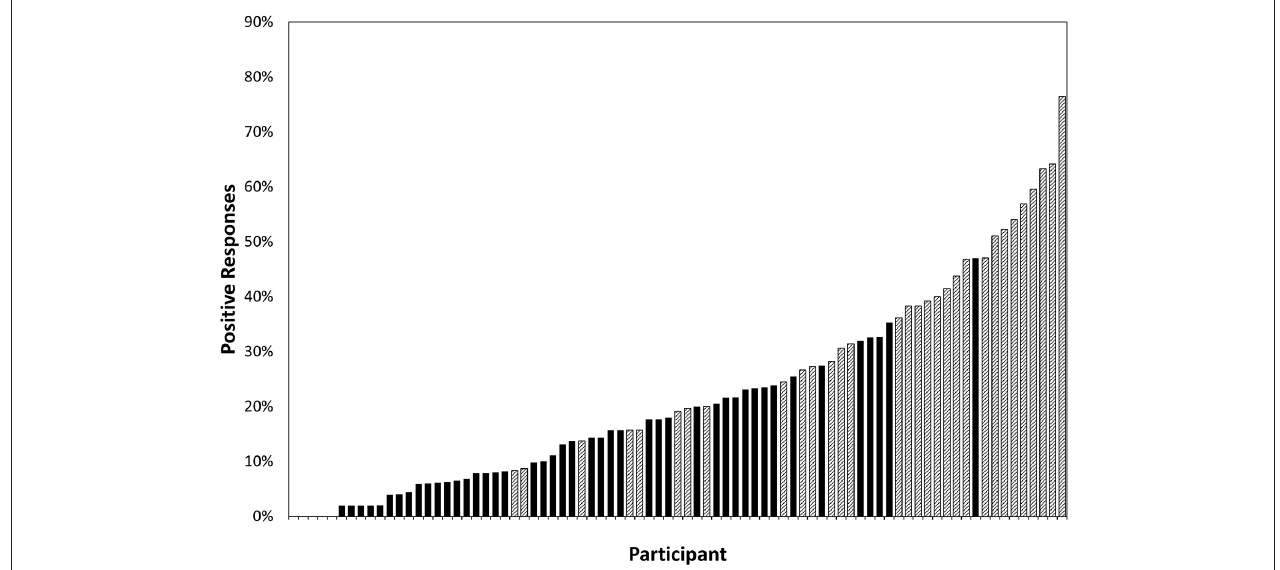
FIGURE 2 | The percentage of questions (excluding those reported as “not applicable”) to which each of 81 participants responded positively (a score of four or five on the question inventory) ranked by increasing number of positive responses; crosshatching represents the participants who fitted the screening criteria for suspected CVI and solid fill represents the participants who did not.